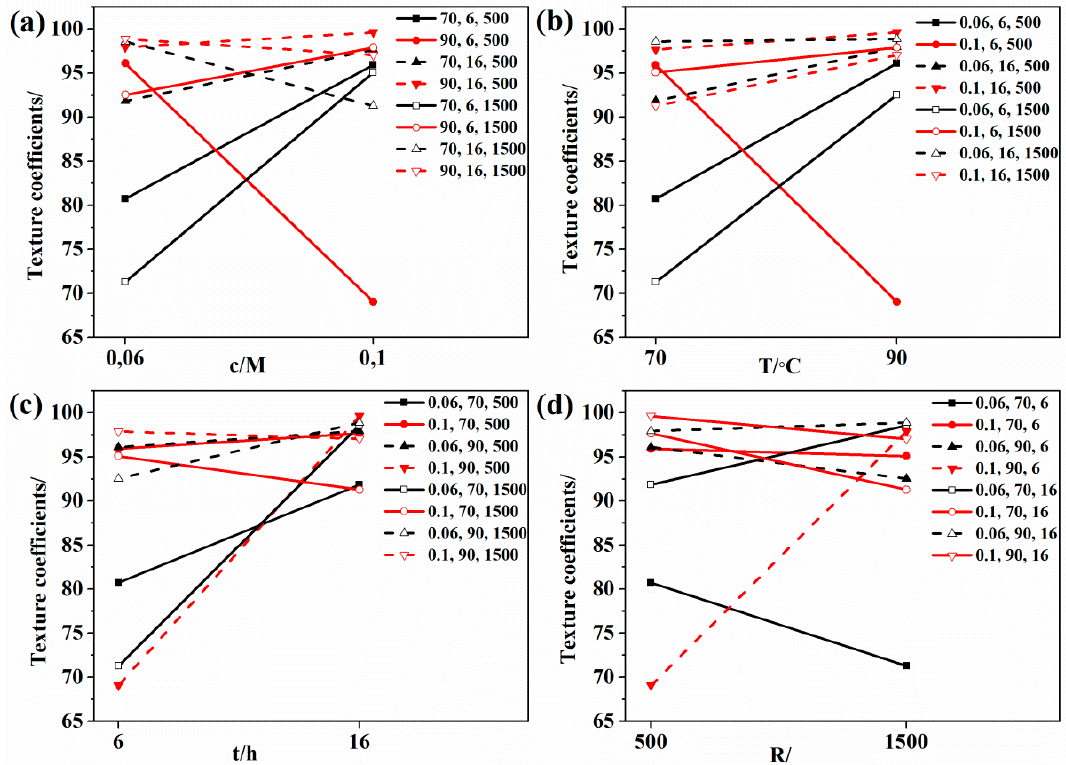
Figure 6. One-pair-at-a-time main effect analysis of varied parameters ( a ) the concentration of Zn 2+ , ( b ) temperature, ( c ) reaction time, and ( d ) molar ration of Zn 2+ to tri-sodium citrate on the texture coefficients for the first sixteen experiments in Table 1.